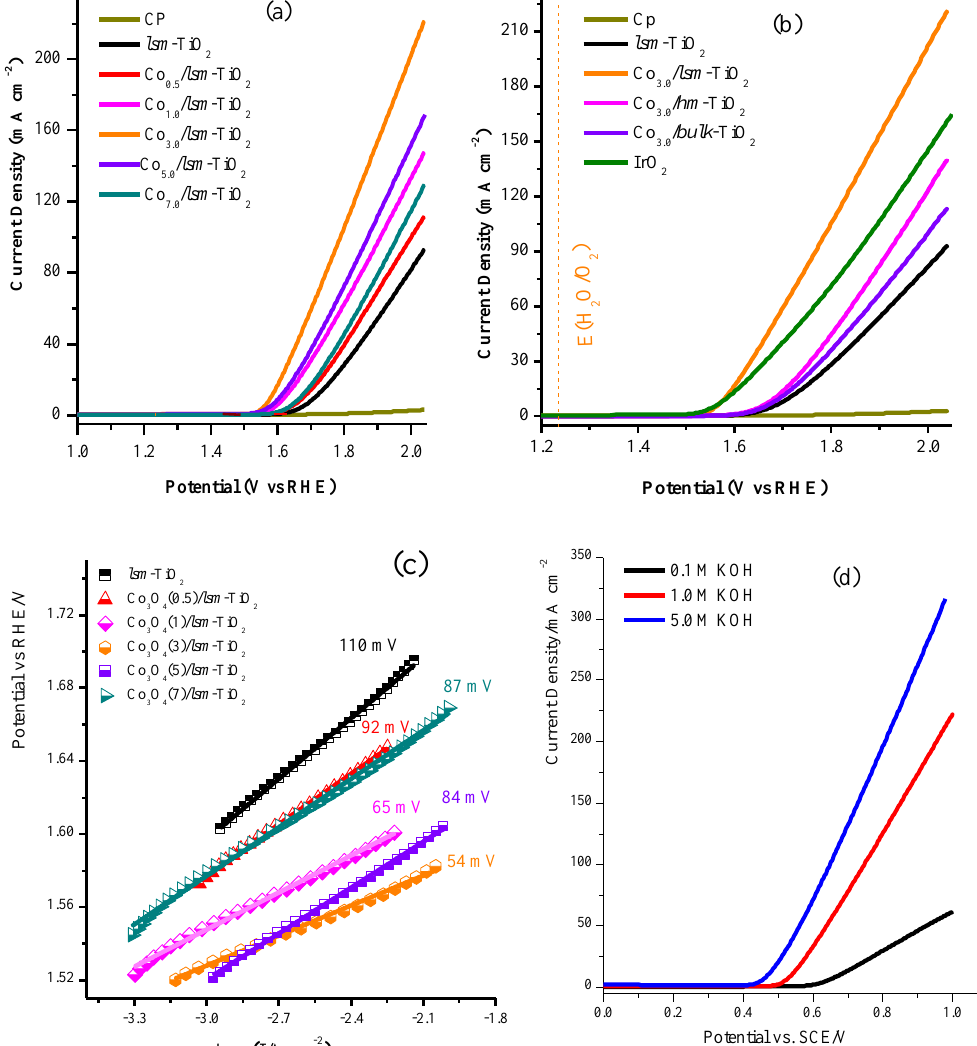
Figure 5. ( a ) The anodic-going sweep of LSV at 10 mV s − 1 for a bare CP, and the Co 3 O 4 ( x ) / lsm -TiO 2 hybrids in 1.0 M of KOH solution (catalyst loading ∼ 0.8 mg / cm 2 for all the electrodes); ( b ) LSV curves of lsm -TiO 2 , Co 3 O 4 (3) / lsm -TiO 2 Co 3 O 4 (3) / hm -TiO 2 , Co 3 O 4 (3) / bulk -TiO 2 , and commercial IrO 2 recorded in 1.0 M of KOH at 10 mV s − 1 ; ( c ) Tafel curves of Co 3 O 4 ( x ) / lsm -TiO 2 as extracted from LSV in ( a ); and ( d ) LSV of Co 3 O 4 (3) / lsm -TiO 2 electrode performed in various KOH concentrations of 0.1, 1.0, and 5.0 M. Table 2. The electrochemical parameters of the mesoporous TiO 2 modified with cobalt oxide nanoparticles, as obtained from the LSV in Figure 5. Onset Catalysts Potential vs. RHE / V Current mass TOF at poten slope activ η =